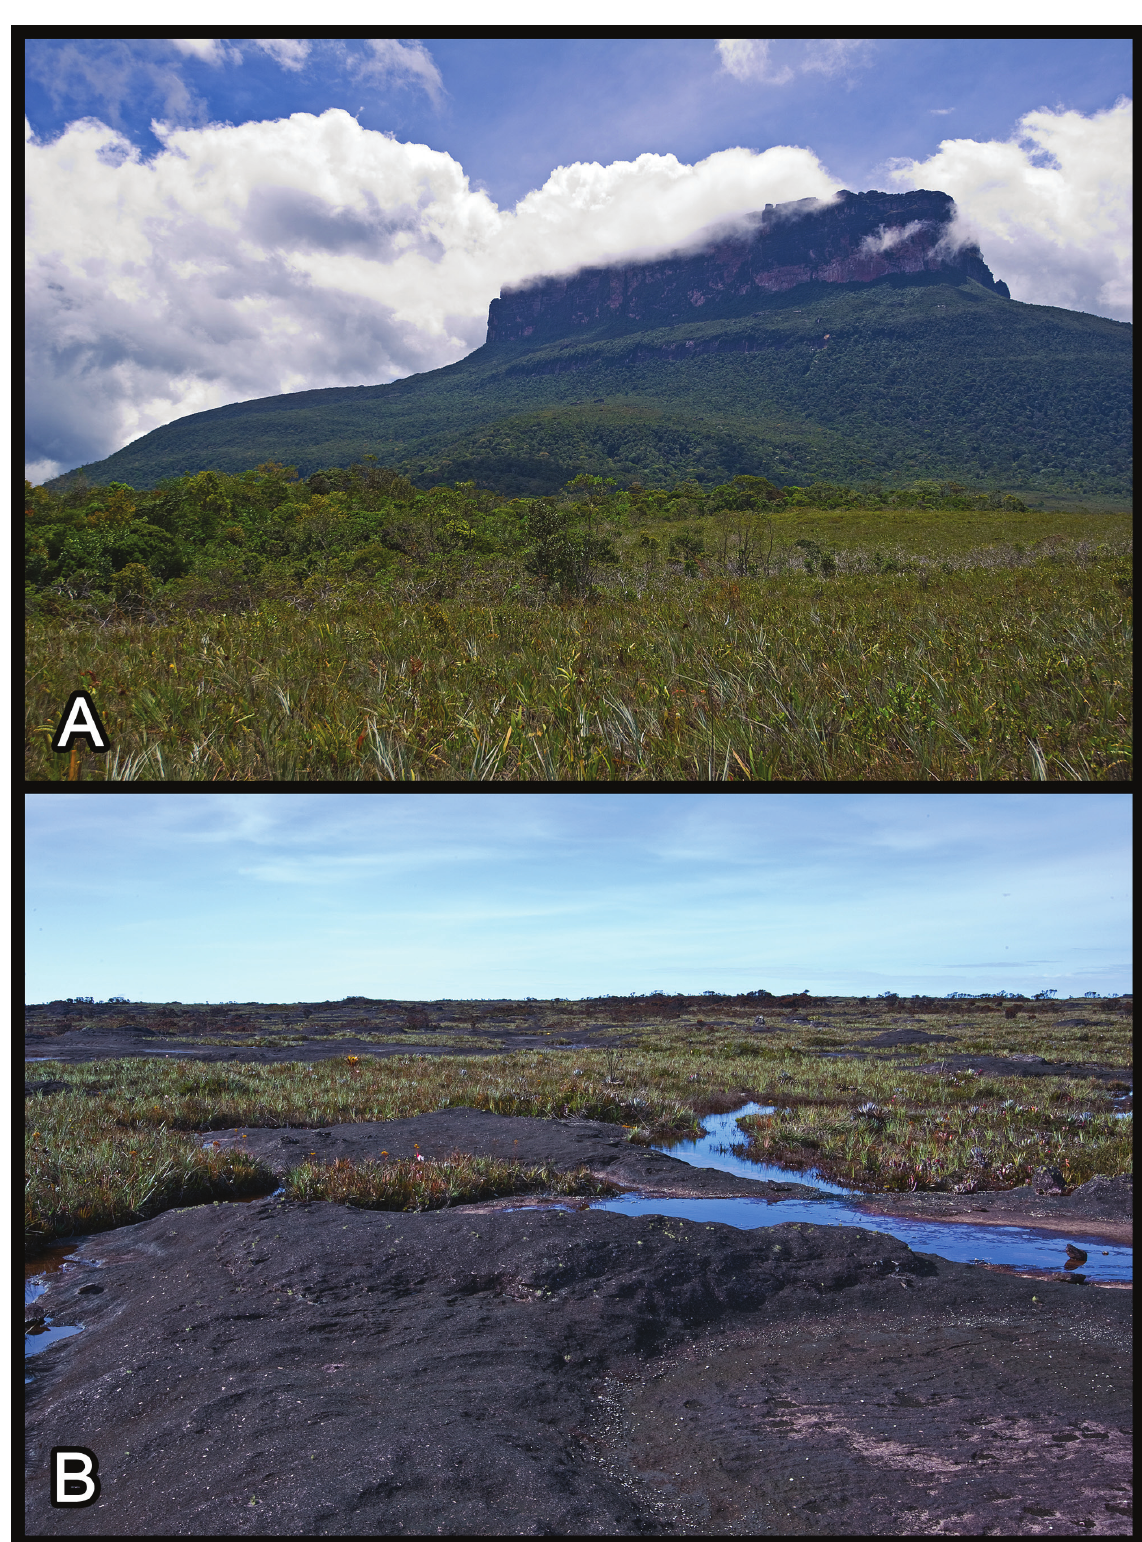
Fig. 11. A . Ptari-tepui, photographed from the surrounding savannah looking to the NE (21 Jun. 2012). B . Summit of Ptari-tepui (21 Jun. 2012). Photographs by the